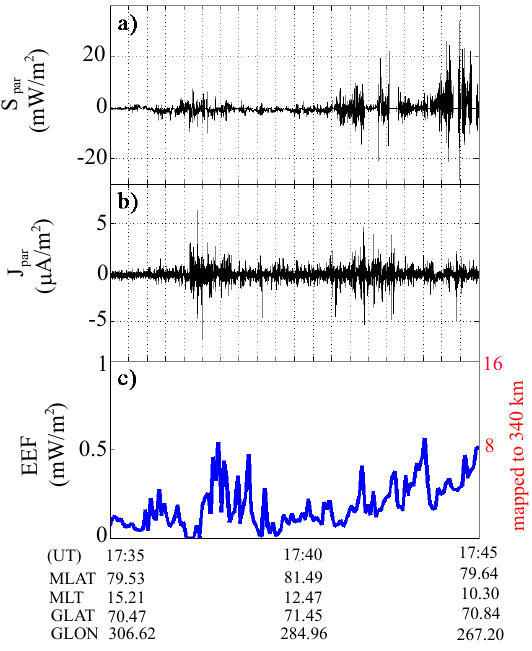
Figure 3. Cluster 4 on 24 June 2009: (a) parallel Poynting flux, (b) parallel current density and (c) electron energy fluxes, where blue colour indicates Earthward direction. Right axis shows EEF mapped to troposphere.